Question: According to the figure, is the described quantity increasing or decreasing?
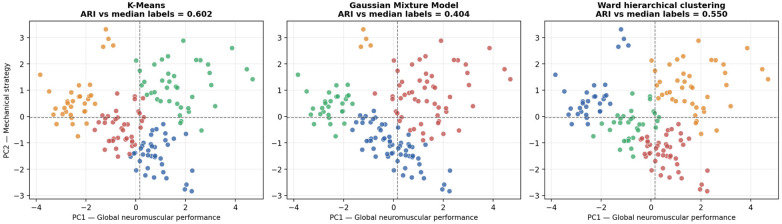
Answer: increasing